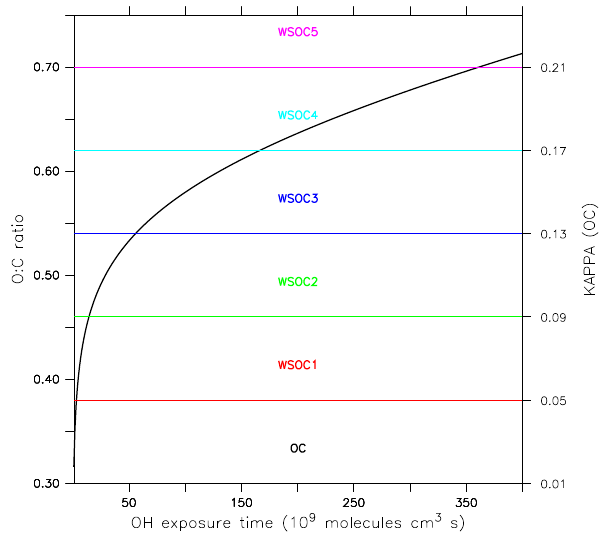
Fig. 1. Schematic curve of ageing of the organic carbon. The hor- izontal axis displays the OH exposure time, whereas the vertical axis show the O:C ratio and corresponding κ values. The horizontal coloured lines represent the threshold values for the O:C ratio for the individual OC